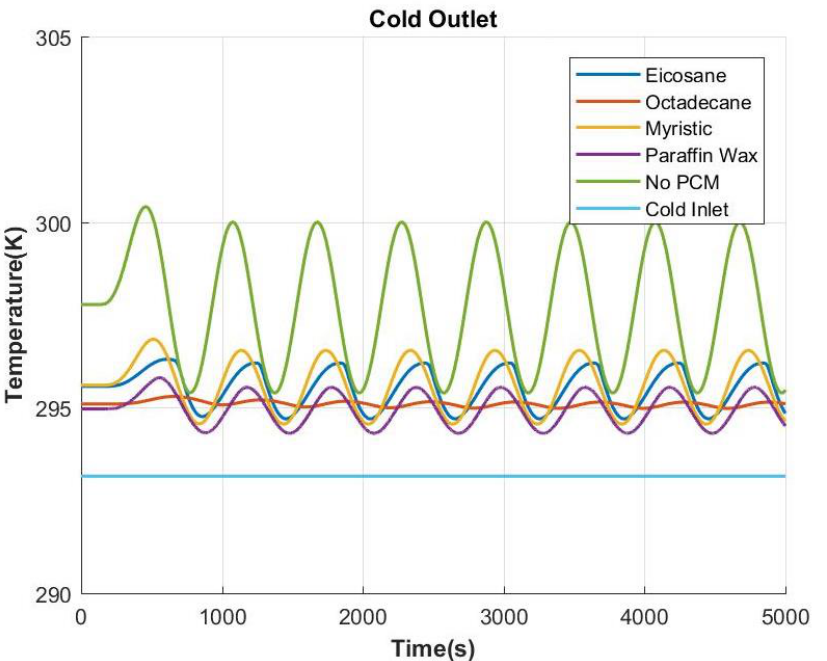
Figure 5. Cold outlets for base case and thermal capacitor cases with four PCMs at Re = 1000, cold inlet temperature is present to show the absolute temperature